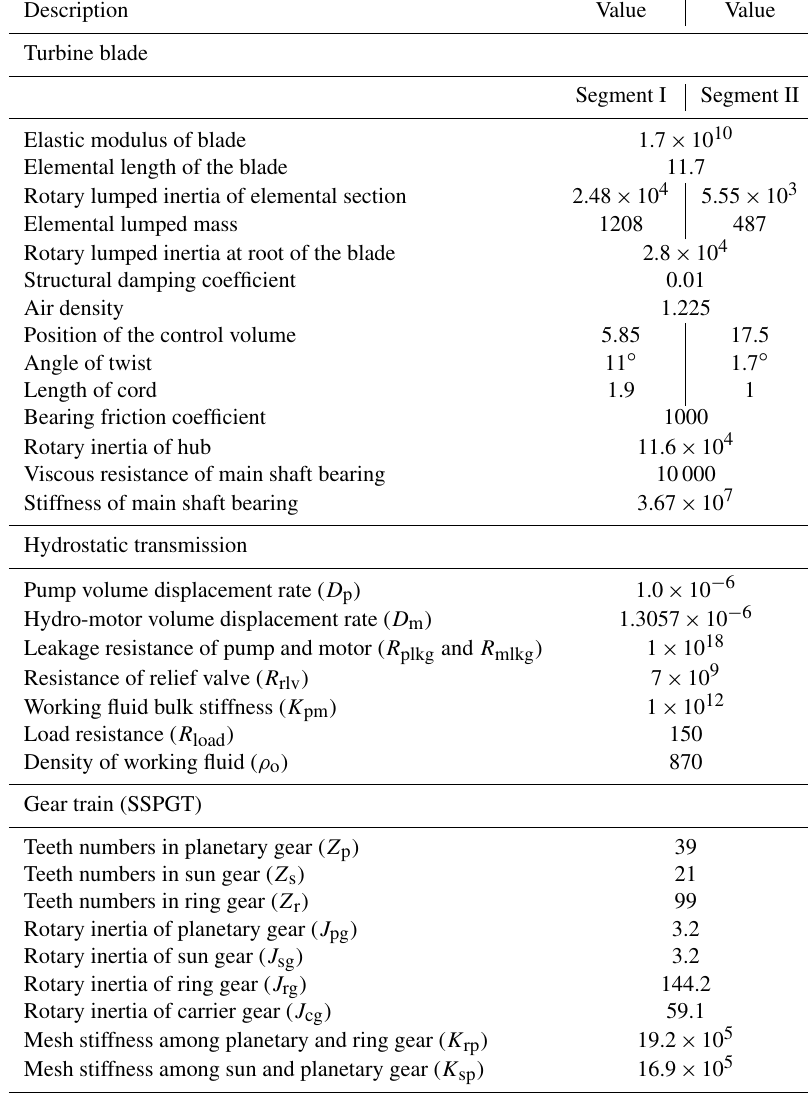
Table 1. Simulation of parameters and